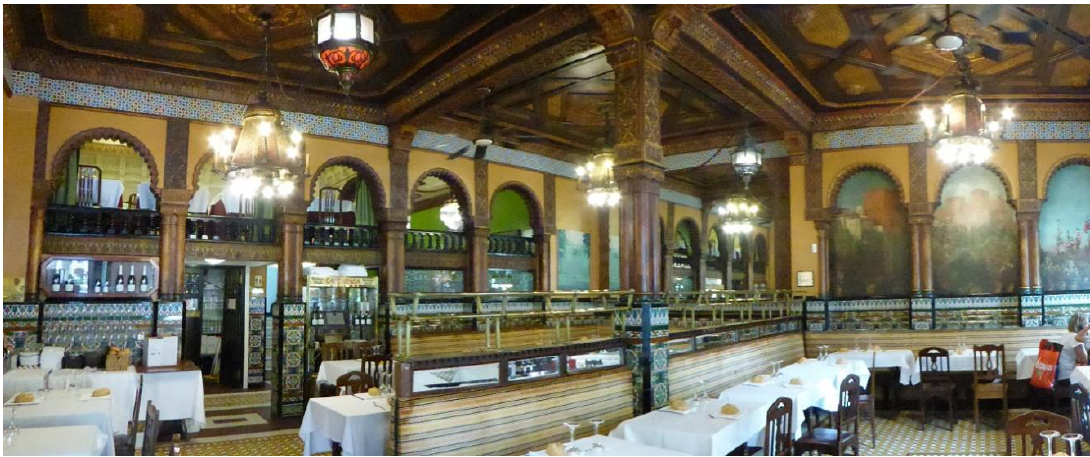
Figure 6. Café Iruña (1903). Bilbao. Photo took by author. Figure 6. Caf é Iruña (1903). Bilbao. Photo took by